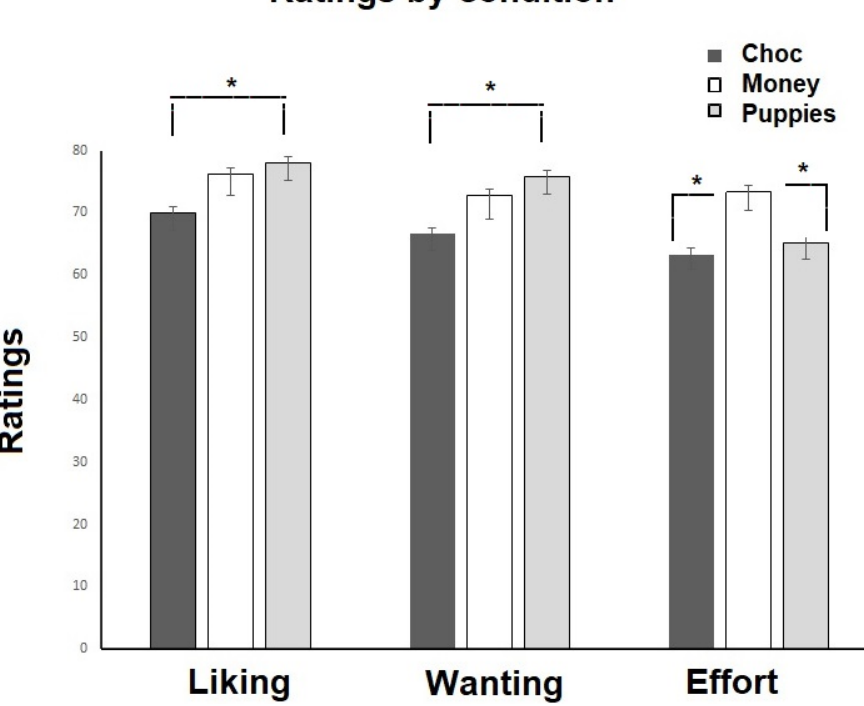
Figure 4. Shows the subjective ratings for liking, wanting and willingness to exert effort for each condition (choc: chocolate, money and puppies). * indicates significant